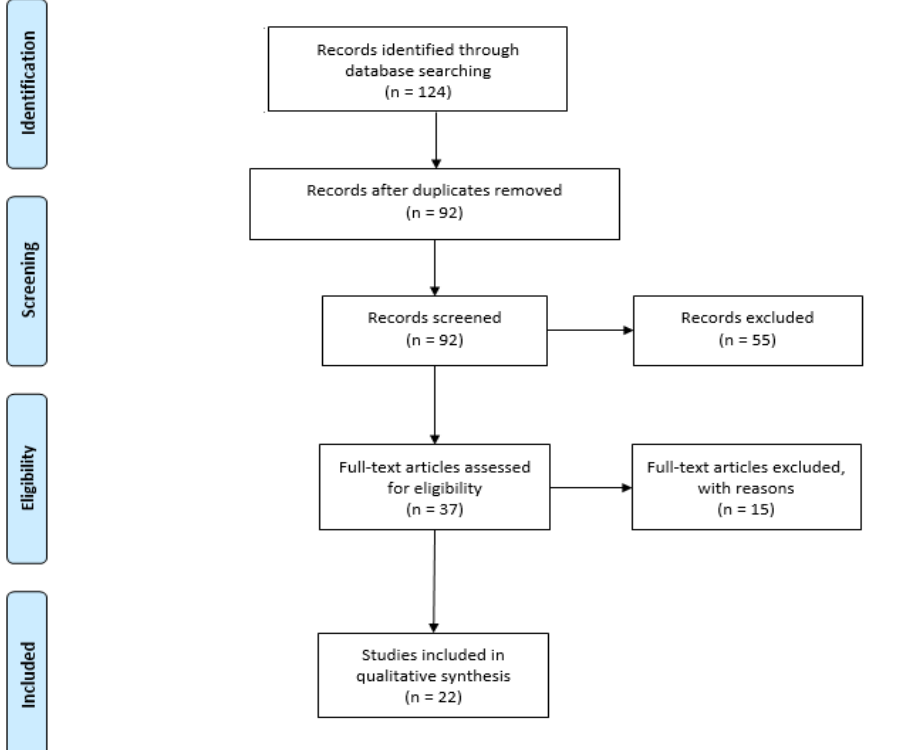
Figure 1. PRISMA process used in the literature review process .